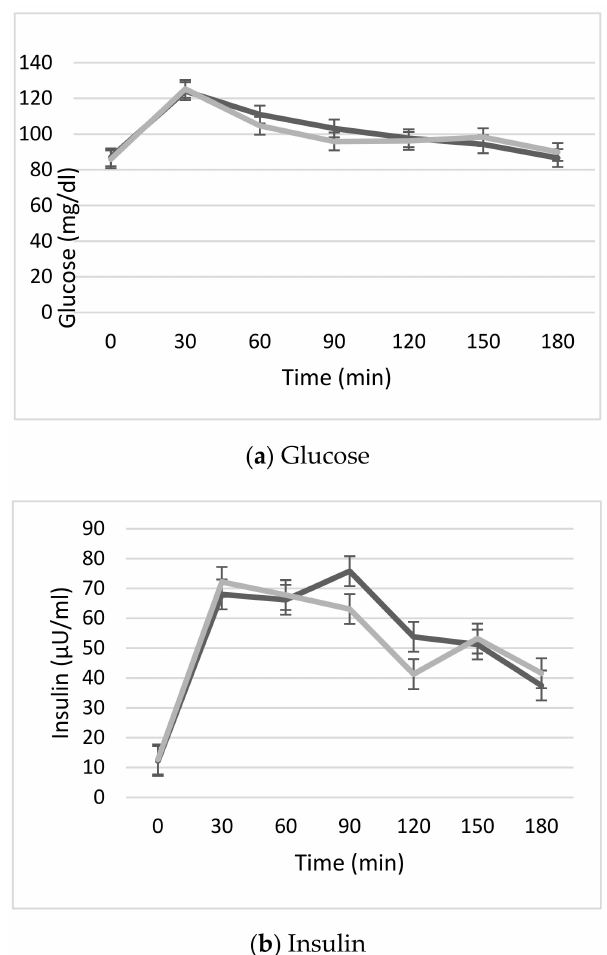
Figure 4. ( a ). Serum glucose (mg / dL) and ( b ). Insulin ( µ U / mL), expressed as mean ± standard error of the mean (SEM) of the 12 participants from the beginning of the test for 3 h, every 30 min. Dark grey: standard pizza. Light grey: seawater pizza.